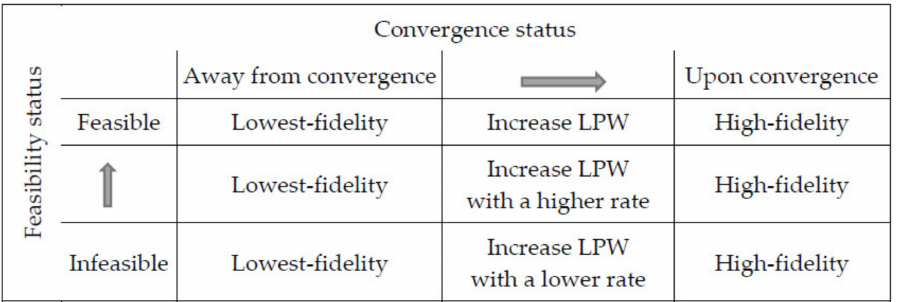
Figure 22. Decision factors for model fidelity adjustment proposed in [46]. The fidelity control depends on the solution feasibility as well as the convergence status of the optimization